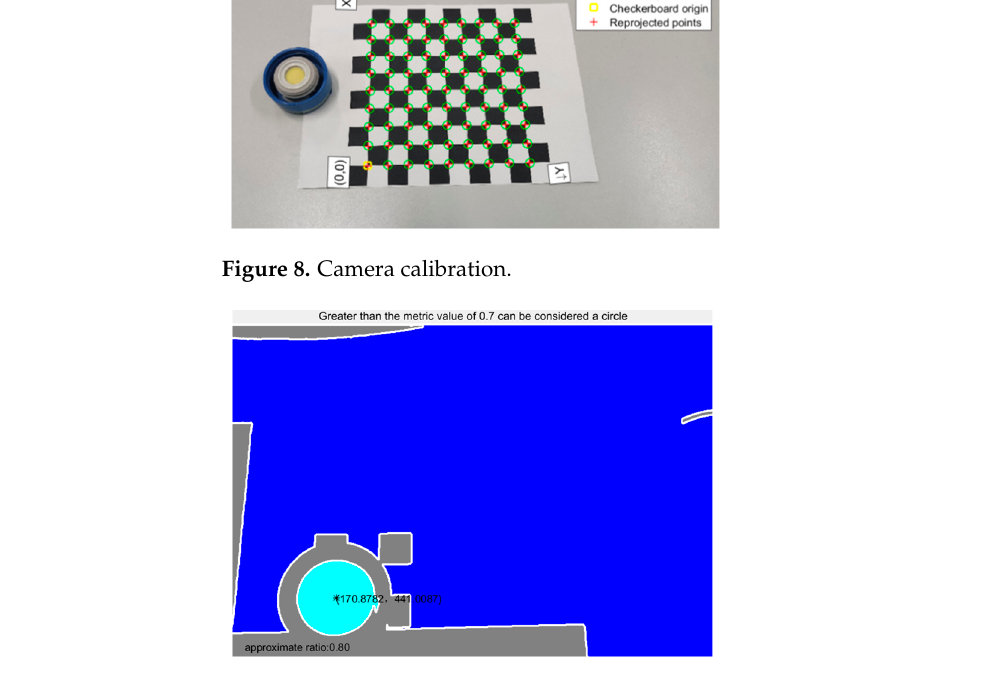
Figure 9. Detection experiment results of the center of the target end face.